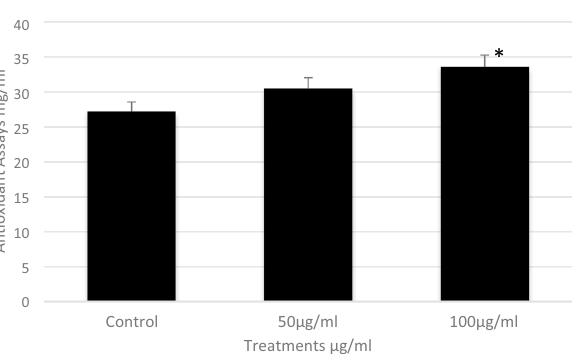
Figure 3. Effects of exposure to ZnO-NPs at concentrations 50 & 100 μg/ml on hemocyte morphology: ( a ) Reducing in cytoplasm, ( b ) Vacuolization in granulocyte, ( c ) Destroyed cell membrane ( d ) Numerous vacuoles covering the cytoplasm, ( e ) Nuclear degeneration, ( f ) Vacuolization in granulacyte ( g ) Protruded cytoplasmic contents ( h , i ), while at concentration100 μg/ml Cytoplasm lysis ( j ) Apoptotic cells ( k ) Mitotic division (X100- oil; bar 5 μm).